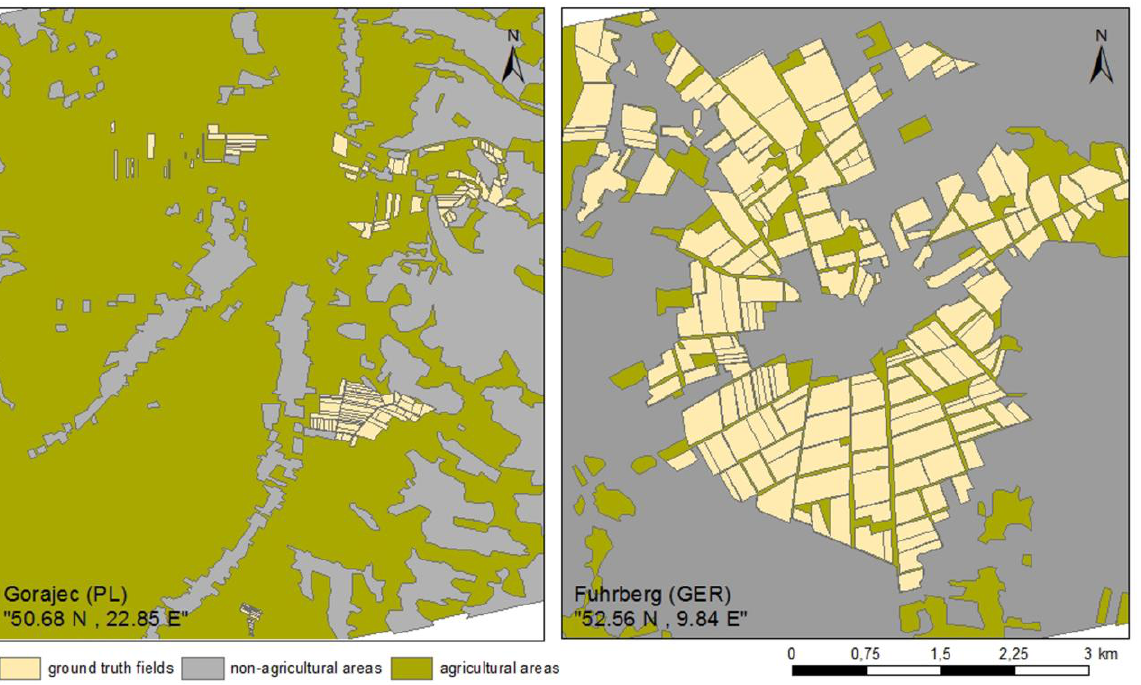
Figure 3. Location of ground truth areas collected in